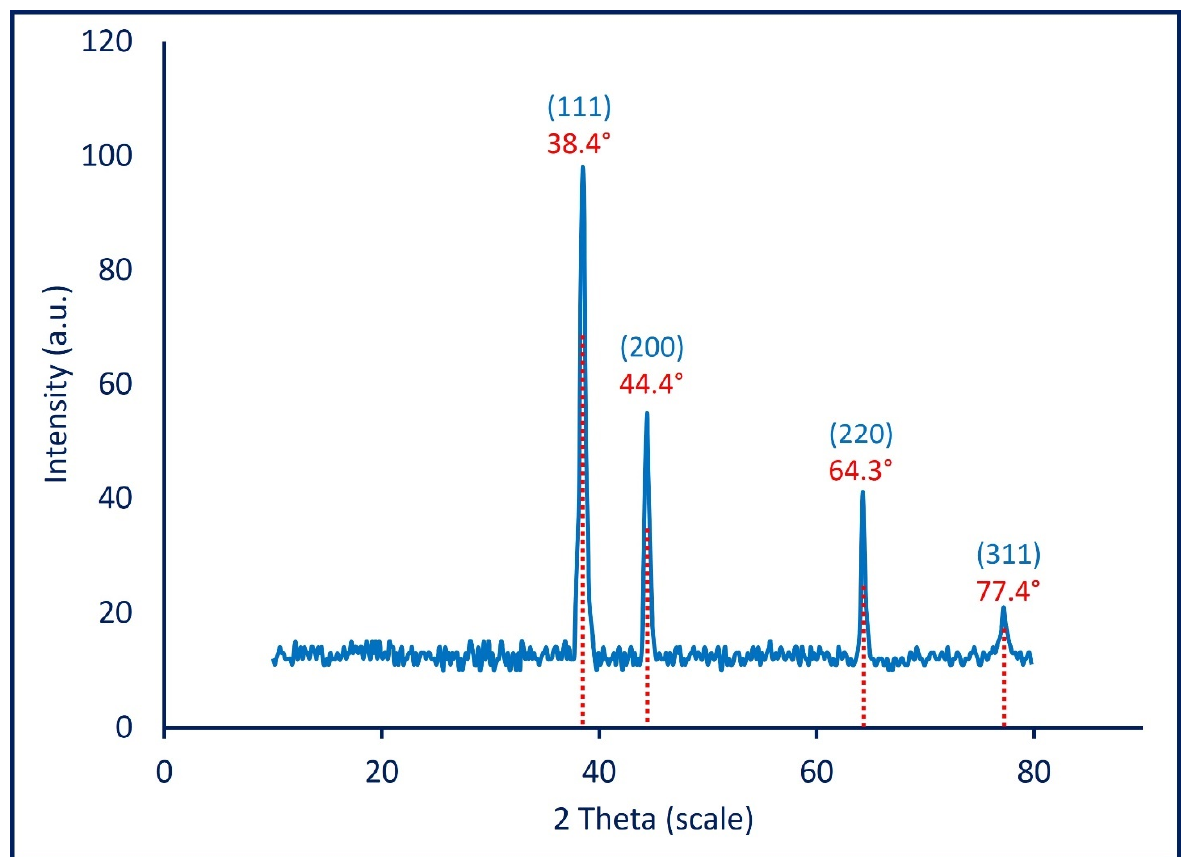
Figure 4. The XRD pattern of mycosynthesized Ag-NPs shows the crystalline